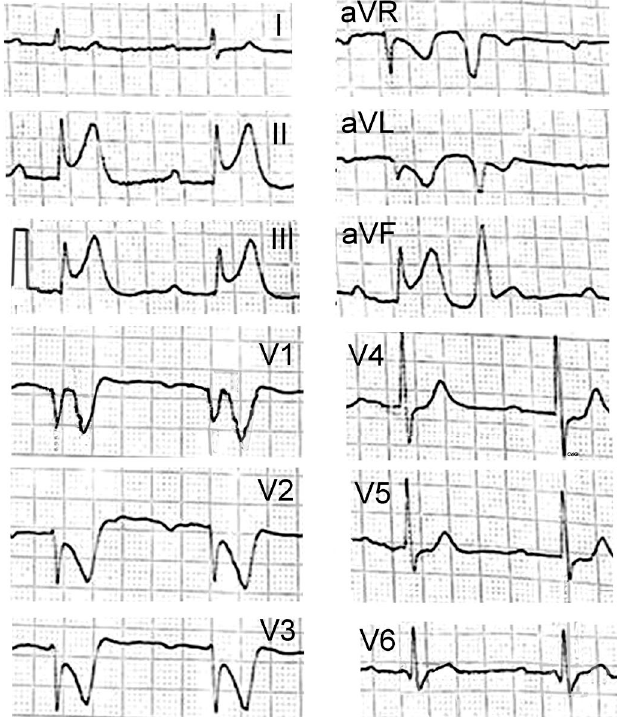
Figure 2. The emergency electrocardiogram, performed under anaphylactic shock conditions, show- ing ST segment elevation in the inferior leads, as well as ST segment depression in the anterior leads with first-degree atrioventricular block.